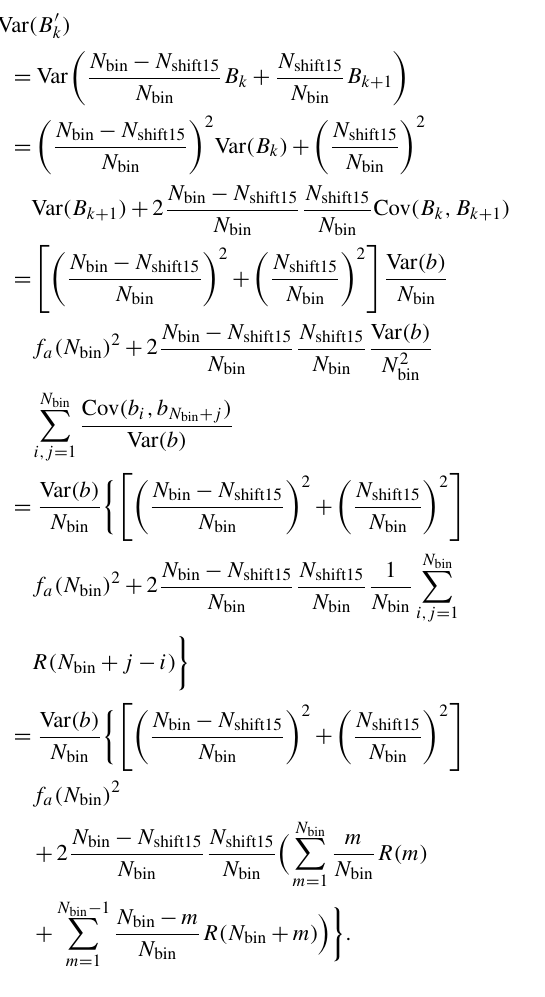
(cid:100) z surf given by a digital elevation model (DEM). The width of this region will vary according to surface type. Since we are = 0), we will only search in a very narrow range of